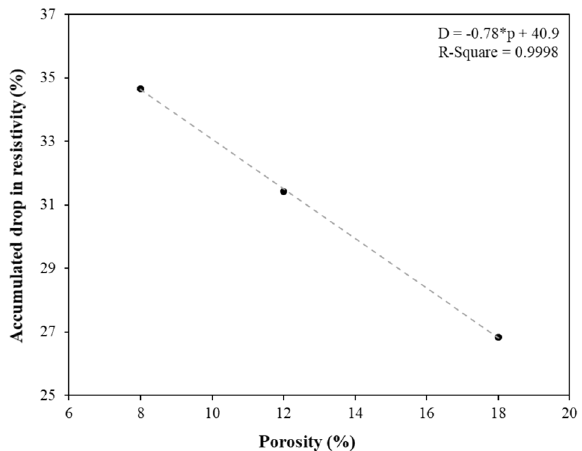
Fig. 4 Accumulated percentage decrease in resistivity with increase of porosity during the transition from room temperature to 700 °C for a proportion of the specimens tested using the ETMT rig. The linear curve fitting formula is provided, where D and p stand for accumulated percentage drop in resistivity and porosity, respectively